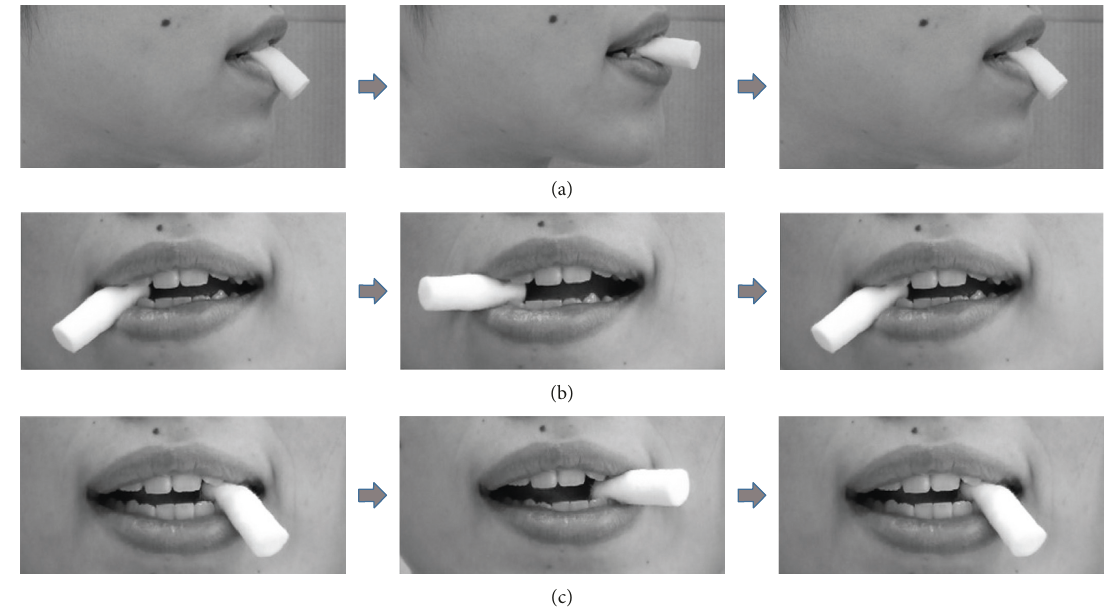
Figure 1: Jaw exercise. (a) Protusion-retrusion jaw movements while biting on a cotton roll with the front teeth. (b) Right jaw movement while biting on a cotton roll with the right canine. (c) Left jaw movement while biting on a cotton roll with the left canine.